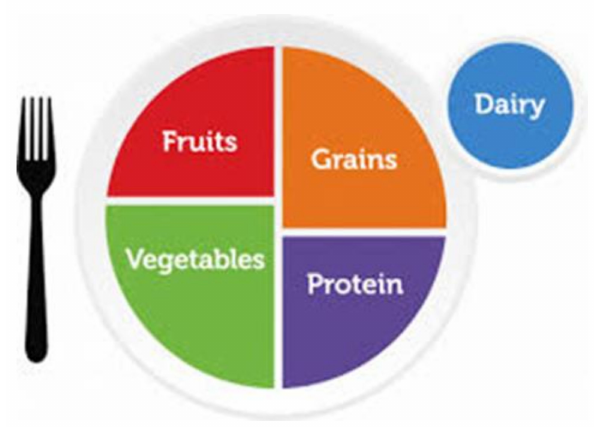
Figure 1. MyPlate